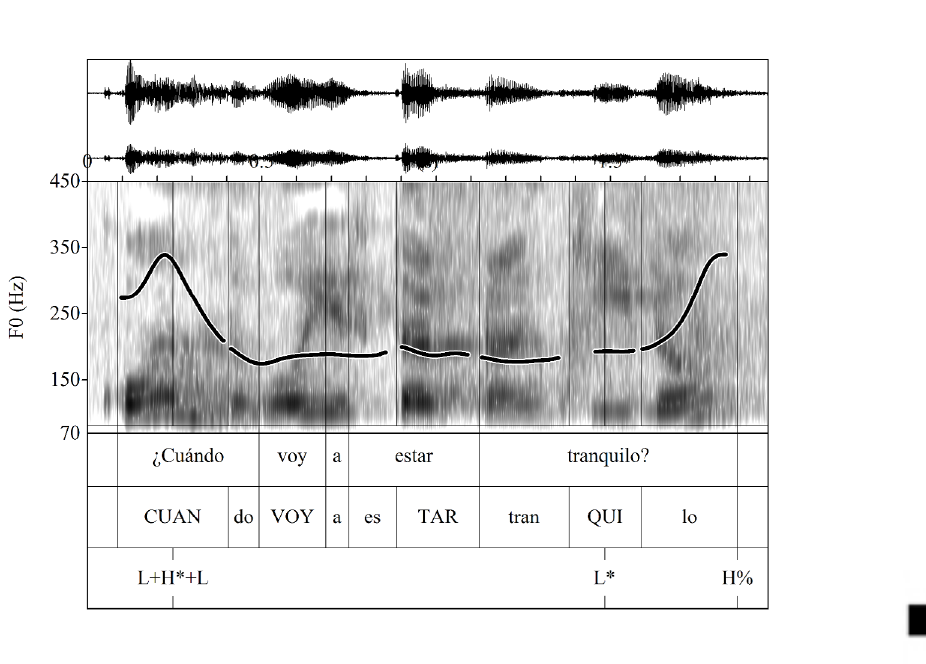
Figure 26 (Participant 17): Waveform and F0 trace for the rhetorical wh- question ¿ Cuándo voy a estar tanquilo? ‘When am I going to be left alone?’ produced as L+H*+L (in 1 st prenuclear position), deaccenting (2 nd and 3 rd prenuclear positions) and as L* H% (in nuclear